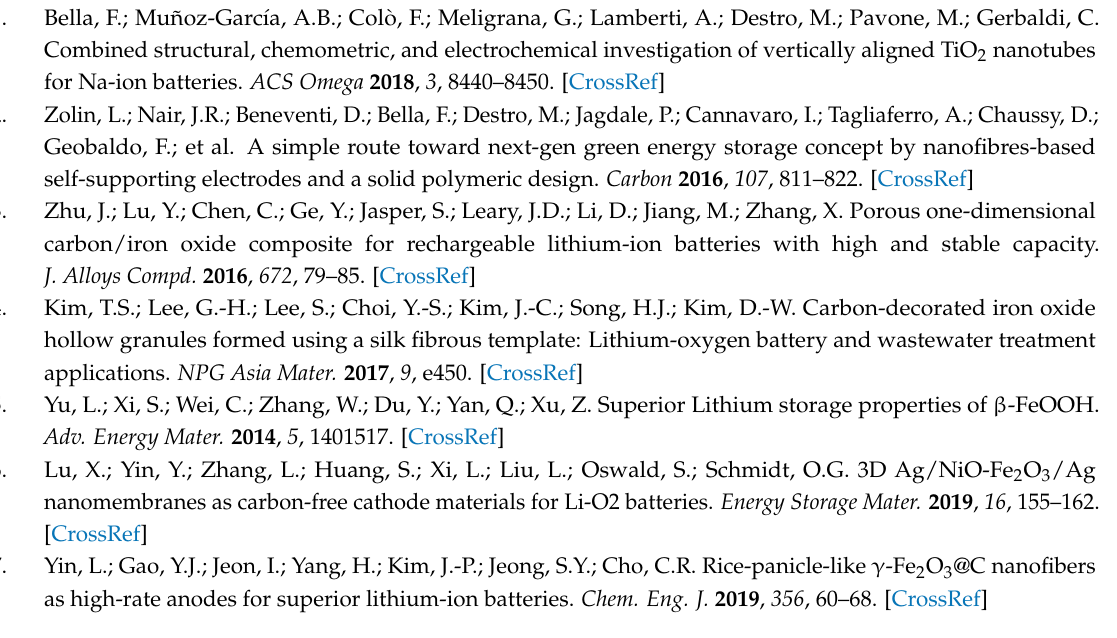
Figure S1: TGA curves (a) for FO samples under oxygen atmosphere; (b) under H 2 :He (3:1) atmosphere for FO samples prepared from precursor solutions of different concentration and (c)under H 2 :He (3:1) atmosphere FO samples obtained at different temperatures, Figure S2: FTIR spectra of FO and FO-800 ◦ C, Figure S3: Schemes of sepiolite structure (a) before and (b) after (dehydrated) thermal treatment; (c) TGA and DTA curves of sepiolite, Figure S4: 29 Si-MAS-RMN spectra and bands assignments for the employed (a) sepiolite and (b) bentonite, Figure S5: Discharge-charge curves of of FO-Sep@C, FO-Ben@C, FO-Sep@C-400, FO-Ben@C-400 and of